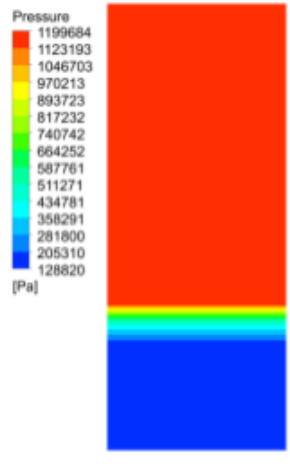
Figure 11: Static pressure in the nozzle averaged along the